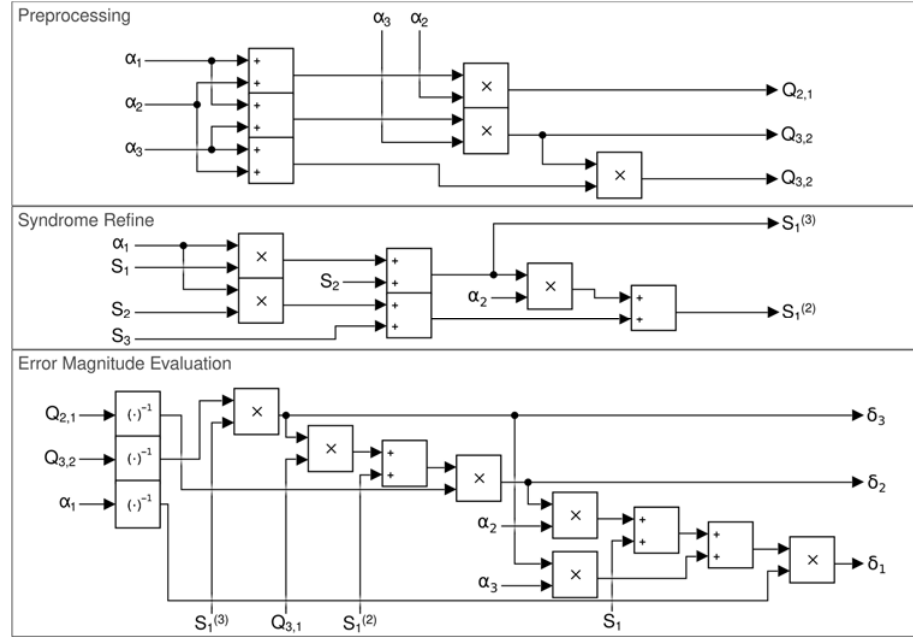
Figure 5. Error magnitude evaluation with ν = 3 implemented with the Lu algorithm. The blocks shown are additions, multiplications, and inversions ( ∙ ) over the Galois field.